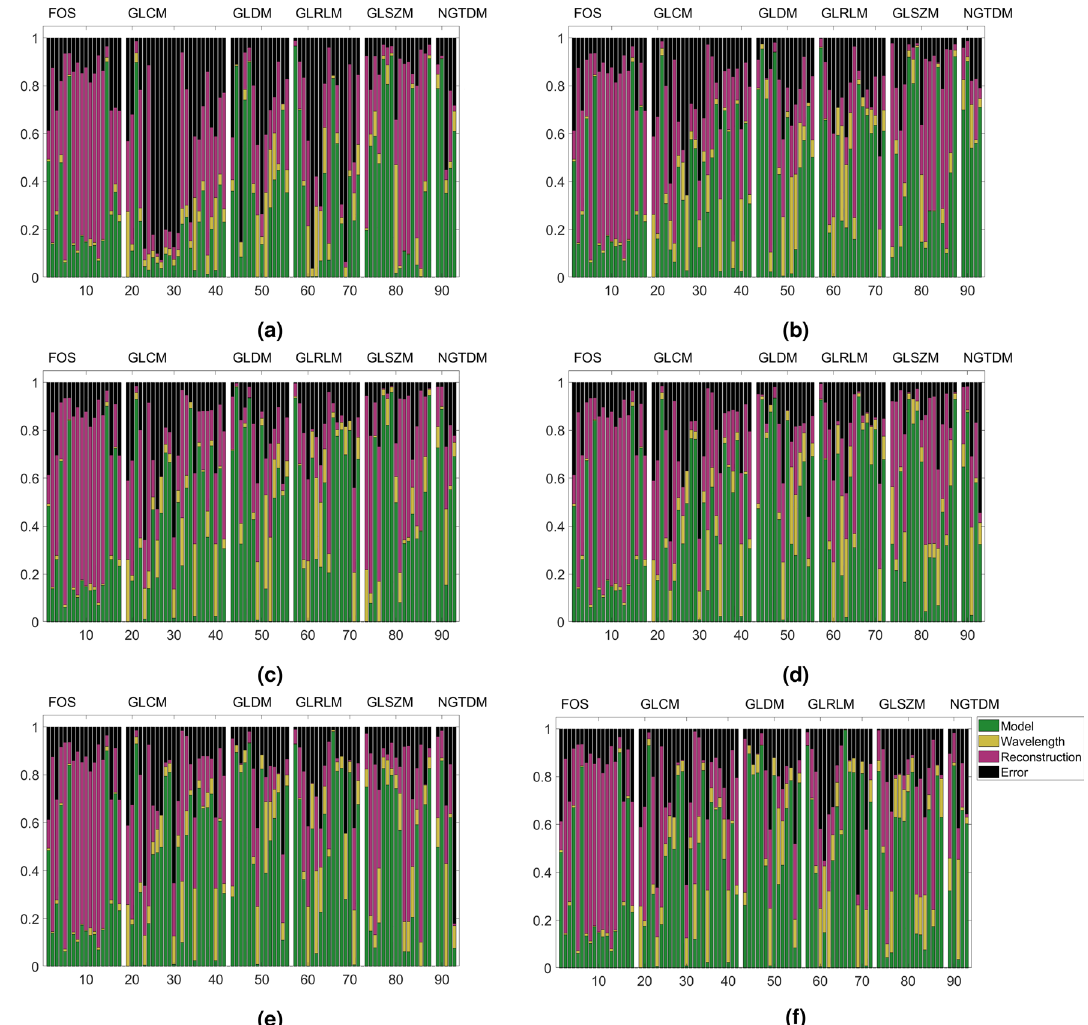
Figure 3. Sensitivity contributions of factors investigated once grey levels have been standardised to ( a ) 8 bins, ( b ) 16 bins, ( c ) 32 bins, ( d ) 64 bins, ( e ) 128 bins and ( f ) 256 bins. The feature IDs (x-axis) follows Supplementary Tables ST1 and ST2.